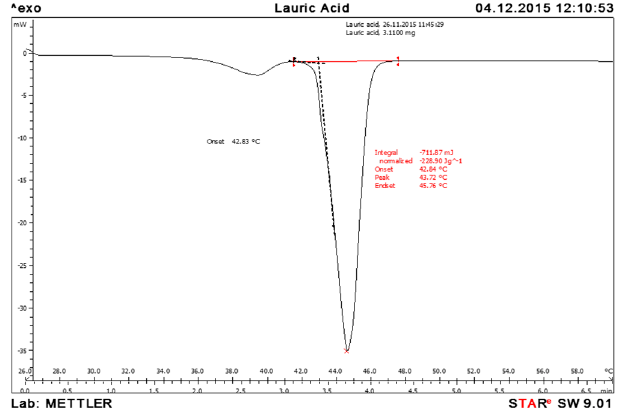
Figure A2. Lauric acid DSC test curve.